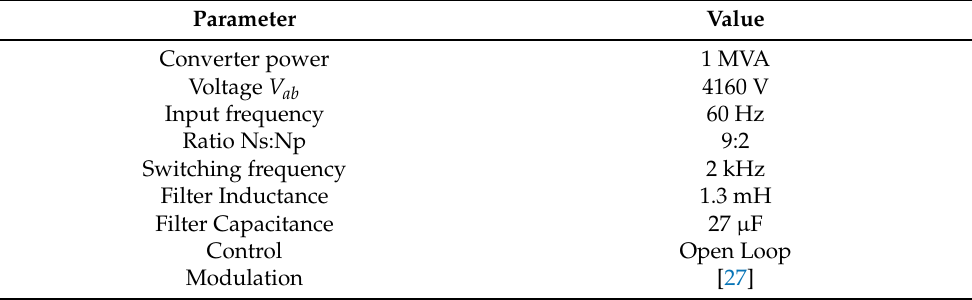
Table 4. Parameters used in MMMC